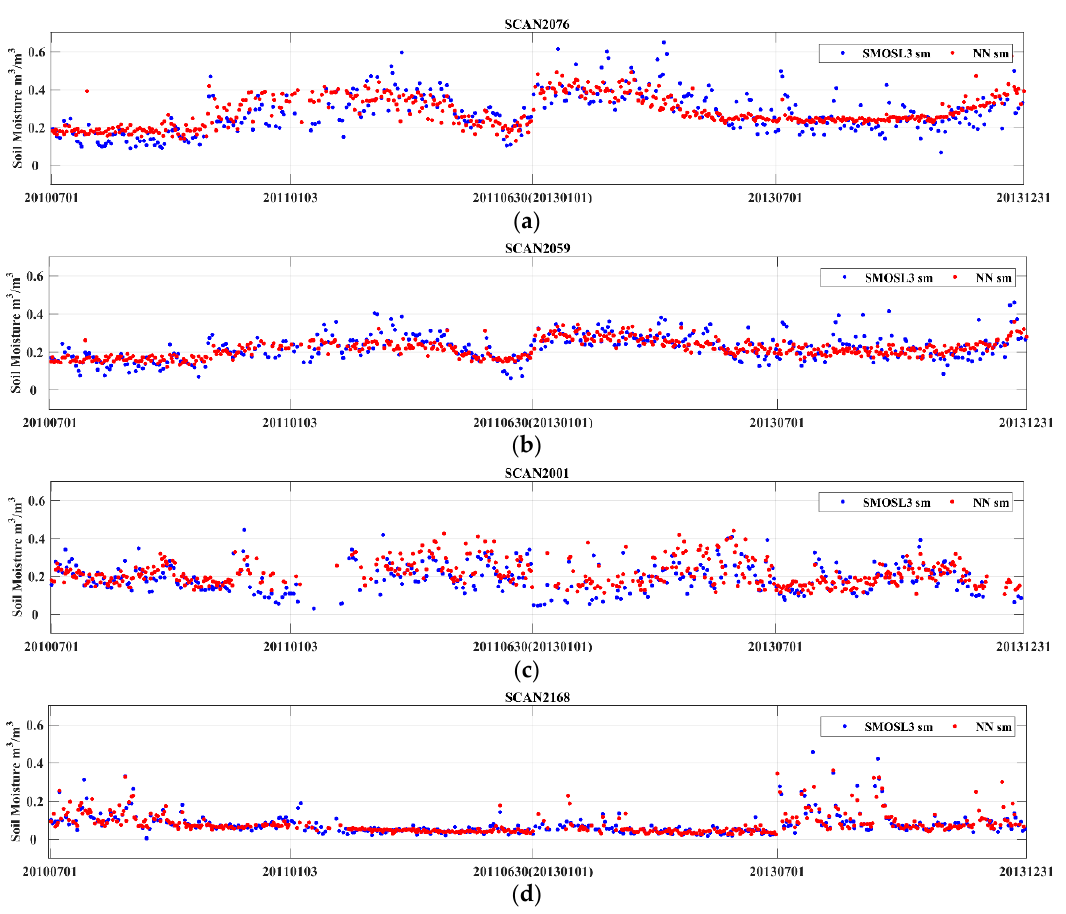
Figure 4. Temporal series scatterplots for trained NNsm (red dots) vs. SMOSL3sm (blue dots)